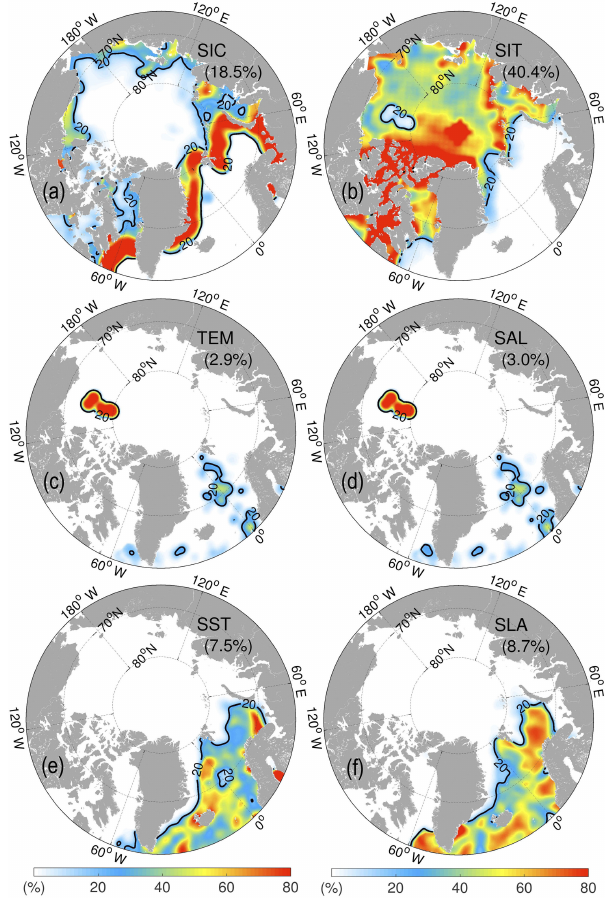
Figure 14. Same as the above but for March